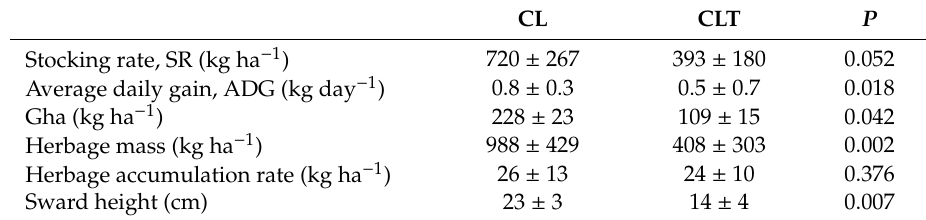
Table 2. Values (means ± standard error) for the characteristics of animal performance in the beef cattle, i.e., stocking rate (SR), average daily gain (ADG) and liveweight gain per hectare (Gha ha − 1 ) and agronomic attributes of the pasture (herbage mass, herbage accumulation rate and sward height) of Lolium multiflorum plus Avena strigosa , within each integrated crop–livestock system (CL, crop–livestock; CLT, crop–livestock–tree systems).